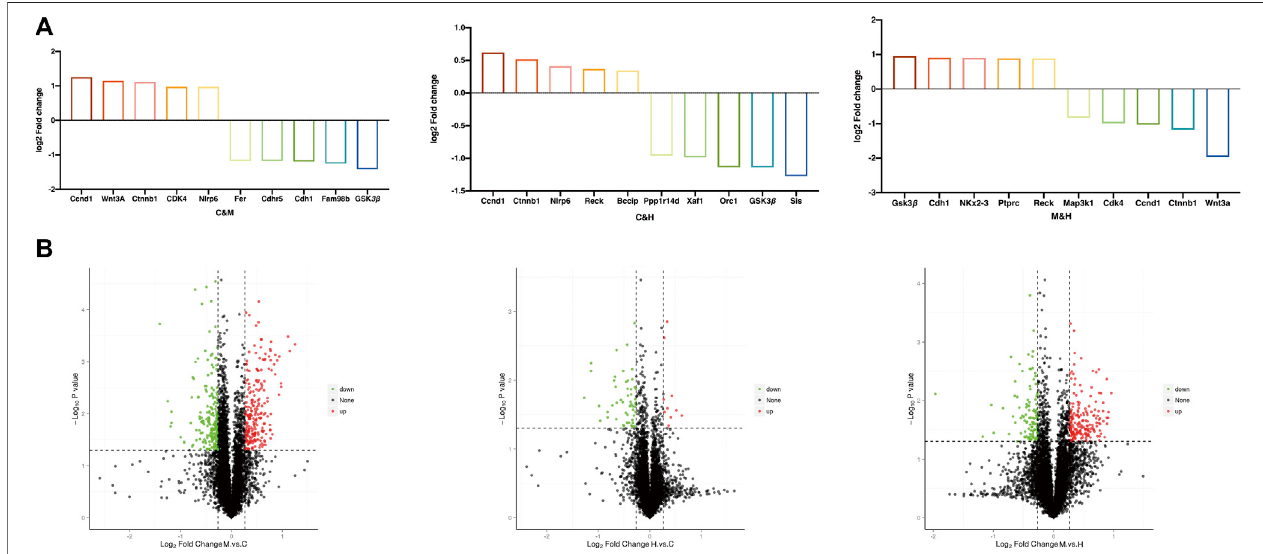
FIGURE 6 | (A) TOP 5 DEPs. The project was selected to screen for upregulated expression proteins when FC ≥ 1.2, while p value ≤ 0.05, and for downregulated expression proteins when FC ≤ 0.83, while p value ≤ 0.05. (B) Volcano map of DEPs. The horizontal coordinate indicates the difference multiplicity of the differential protein (log2 value), and the vertical axis indicates the p value ( − log10 value). Black represents proteins with no signi fi cant differences, red represents upregulated proteins, and green represents downregulated proteins. C: normal control; M: model control; H: HQT control, n = 3.